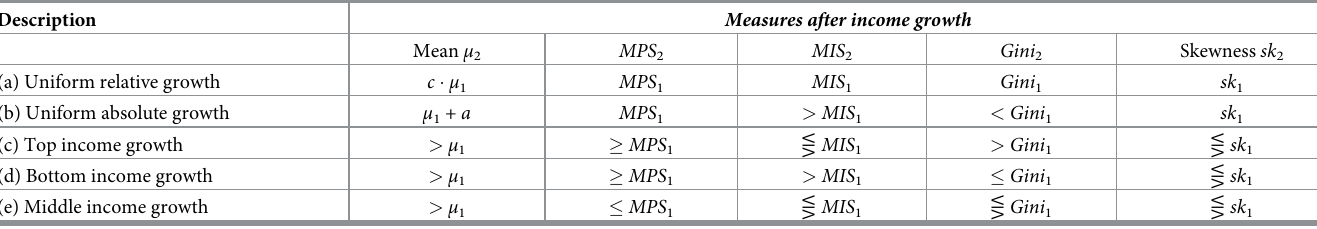
Table 1. Comparison of measures in the growth scenarios from theorem 1.